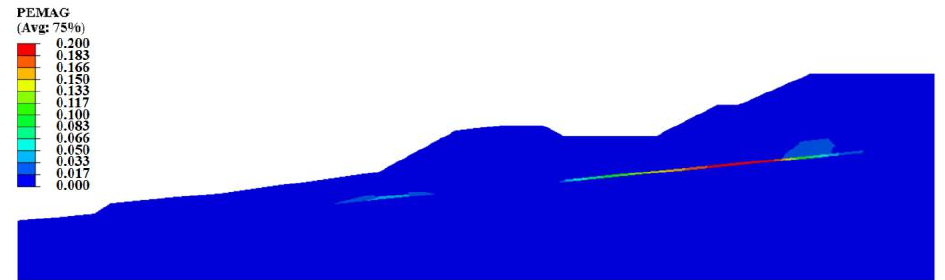
Figure 7. Slope plastic zone.